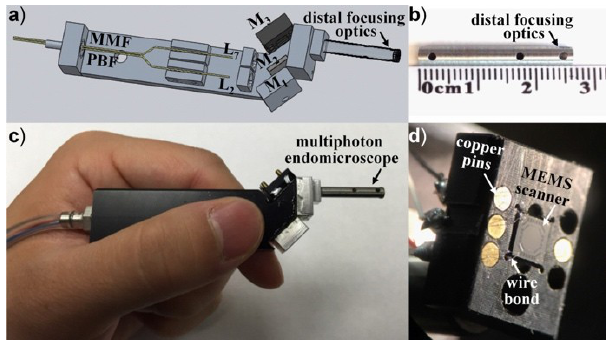
Figure 12. MEMS-based two-photon microendoscope. ( a ) Schematic CAD drawing of the optical circuit. ( b ) Distal end of focusing optics. ( c ) Handheld instrument which is used to perform repetitive imaging in small animal models of human disease. ( d ) Photograph of the MEMS scanner wire bonded on the substrate. Reproduced with permission from [78]; published by OSA, 2015.